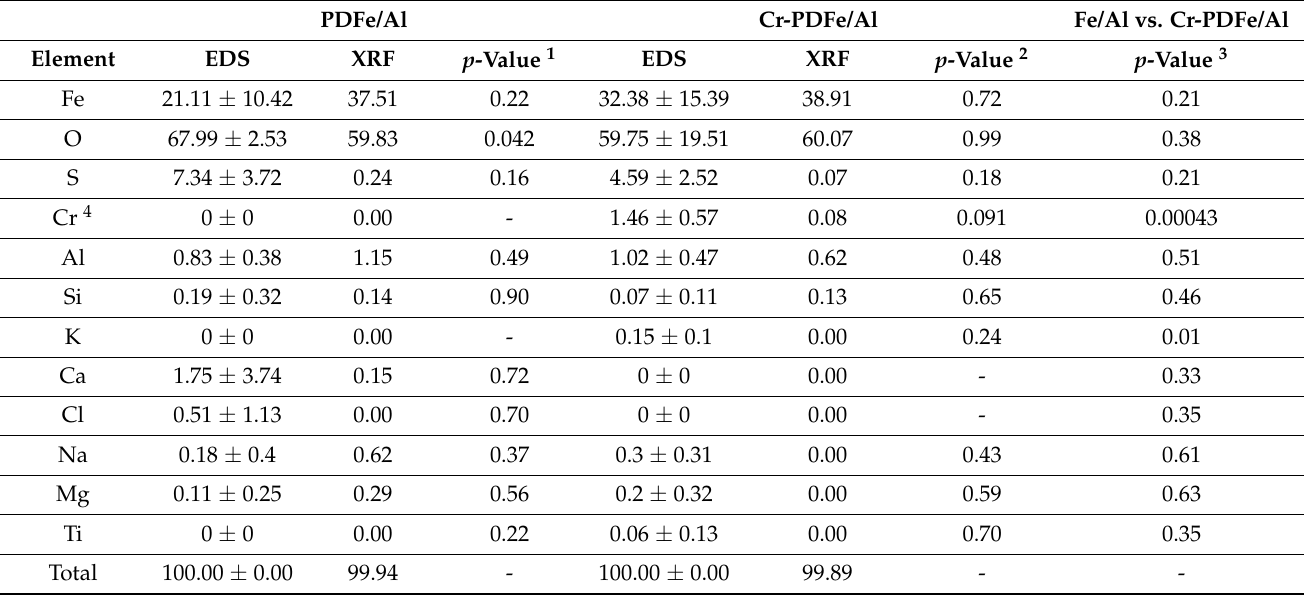
Table 3. EDS and XRF mole percentage results.